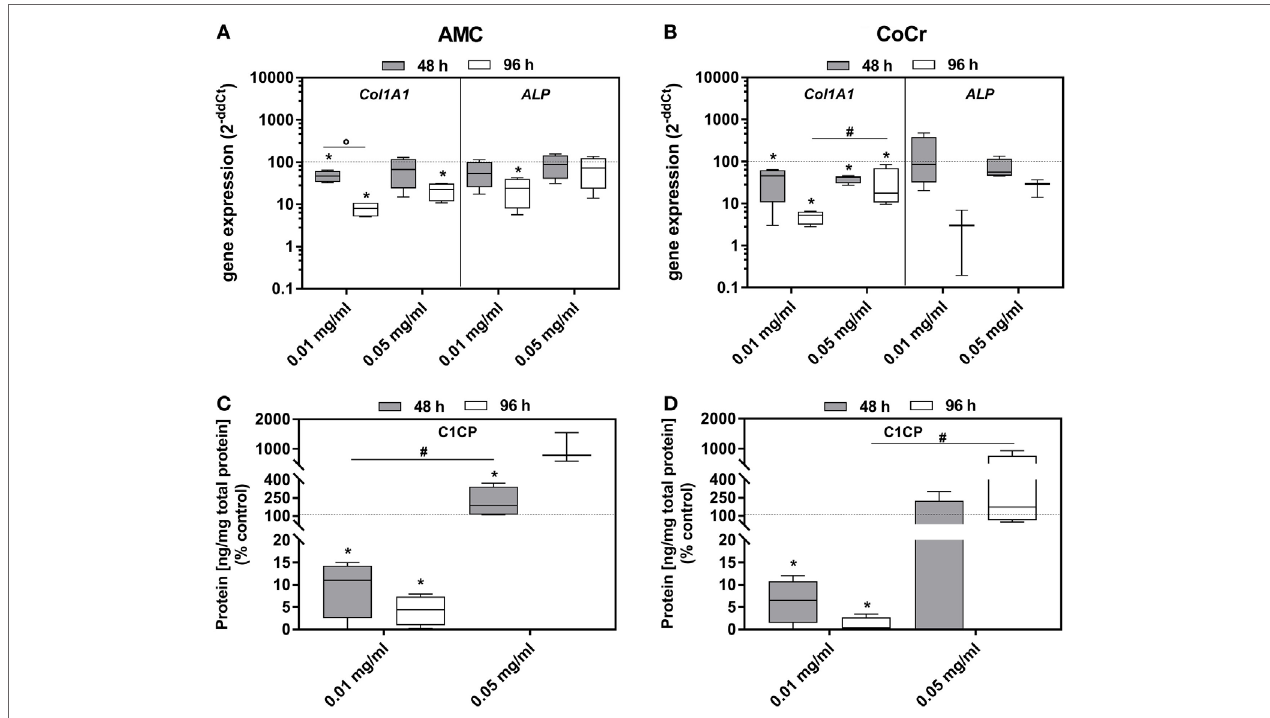
FigUre 5 | Differentiation capacity of human osteoblasts after exposure to different concentrations of AMC and CoCr particles. Cells were treated with the respective particle to evaluate gene expression levels of osteogenic differentiation marker by qRT-PCR (a,B) . (c,D) Cell culture supernatants were used to evaluate the concentration of pro-collagen type 1 (C1CP per total protein content). Data are shown as box plots ( n ≥ 3). Significances between groups were calculated with the Mann–Whitney U -test (* p < 0.05, treated vs. untreated; # p < 0.05, 0.01 vs. 0.05 mg/ml; ° p < 0.05, 48 vs. 96